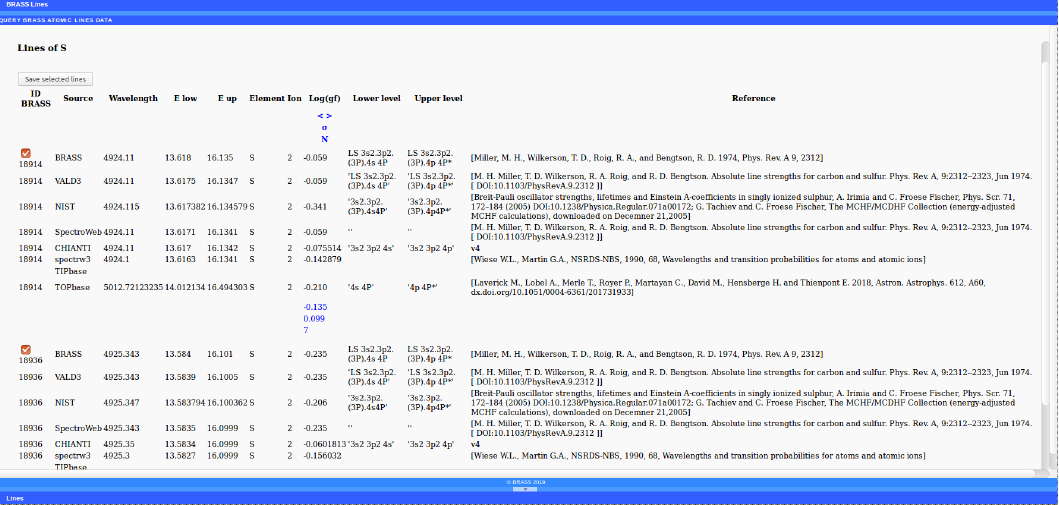
Figure 2. BRASS query results table for S lines sorted by wavelength. The lines data are cross-matched with various atomic databases and the corresponding literature references are also